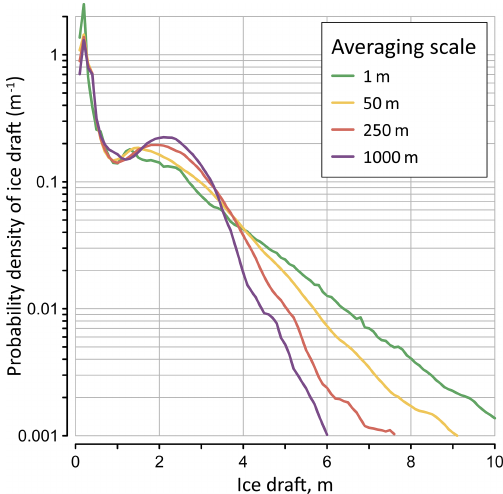
Figure 15. Impact of along-track averaging on the probability den- sity of ice